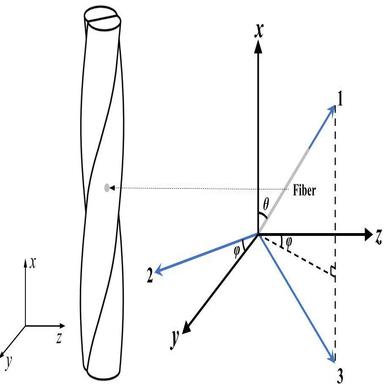
Schematic diagram of the relationship between the local coordinate system related to fiber orientation and the global coordinate system.